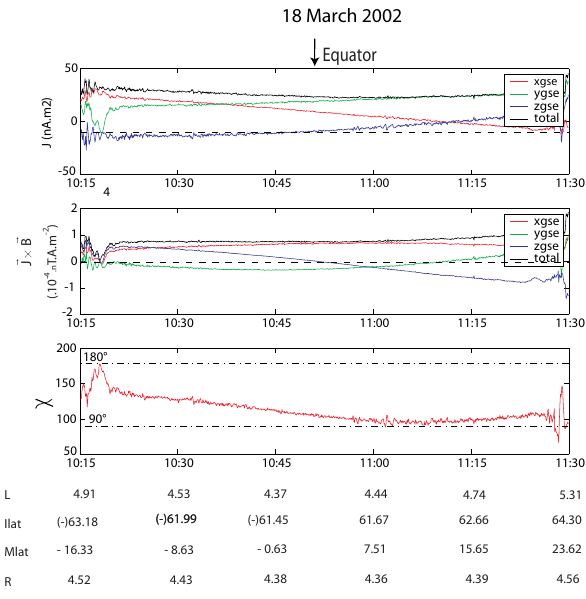
Fig. 11. Curlometer results for the 18 March 2002 event. From top to bottom: current density in the GSE coordinate system, pressure gradient (computed from J × B ) , and χ angle between local current flow and magnetic field. L-shell, invariant latitudes, magnetic lat- itudes and geocentric distances are indicated at the bottom of the